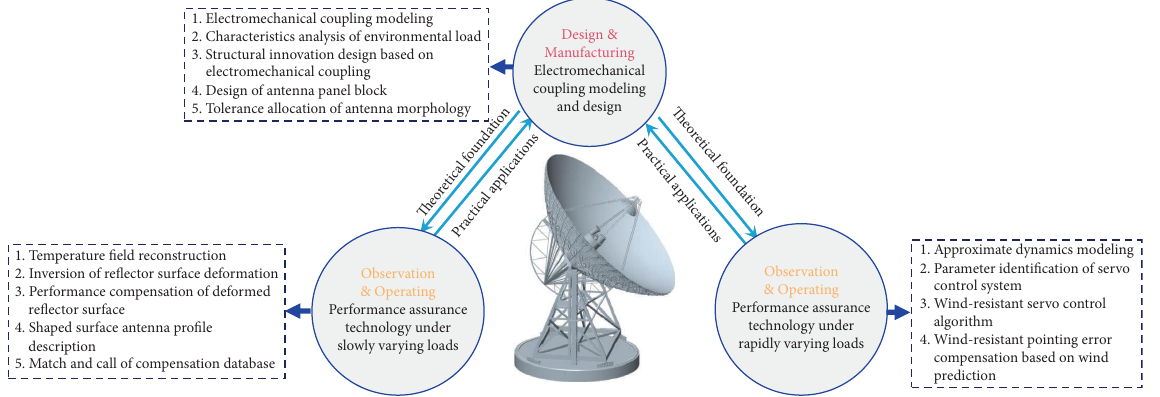
Figure 19: Electromechanical coupling technology for radio